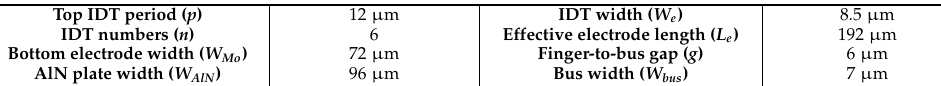
Figure 1. ( a ) Schematic view and ( b ) Cross-section schematic of the designed AlN LWR with extended lateral reflection boundary conditions. Table 1. The main geometric dimensions of the designed AlN LWRs.